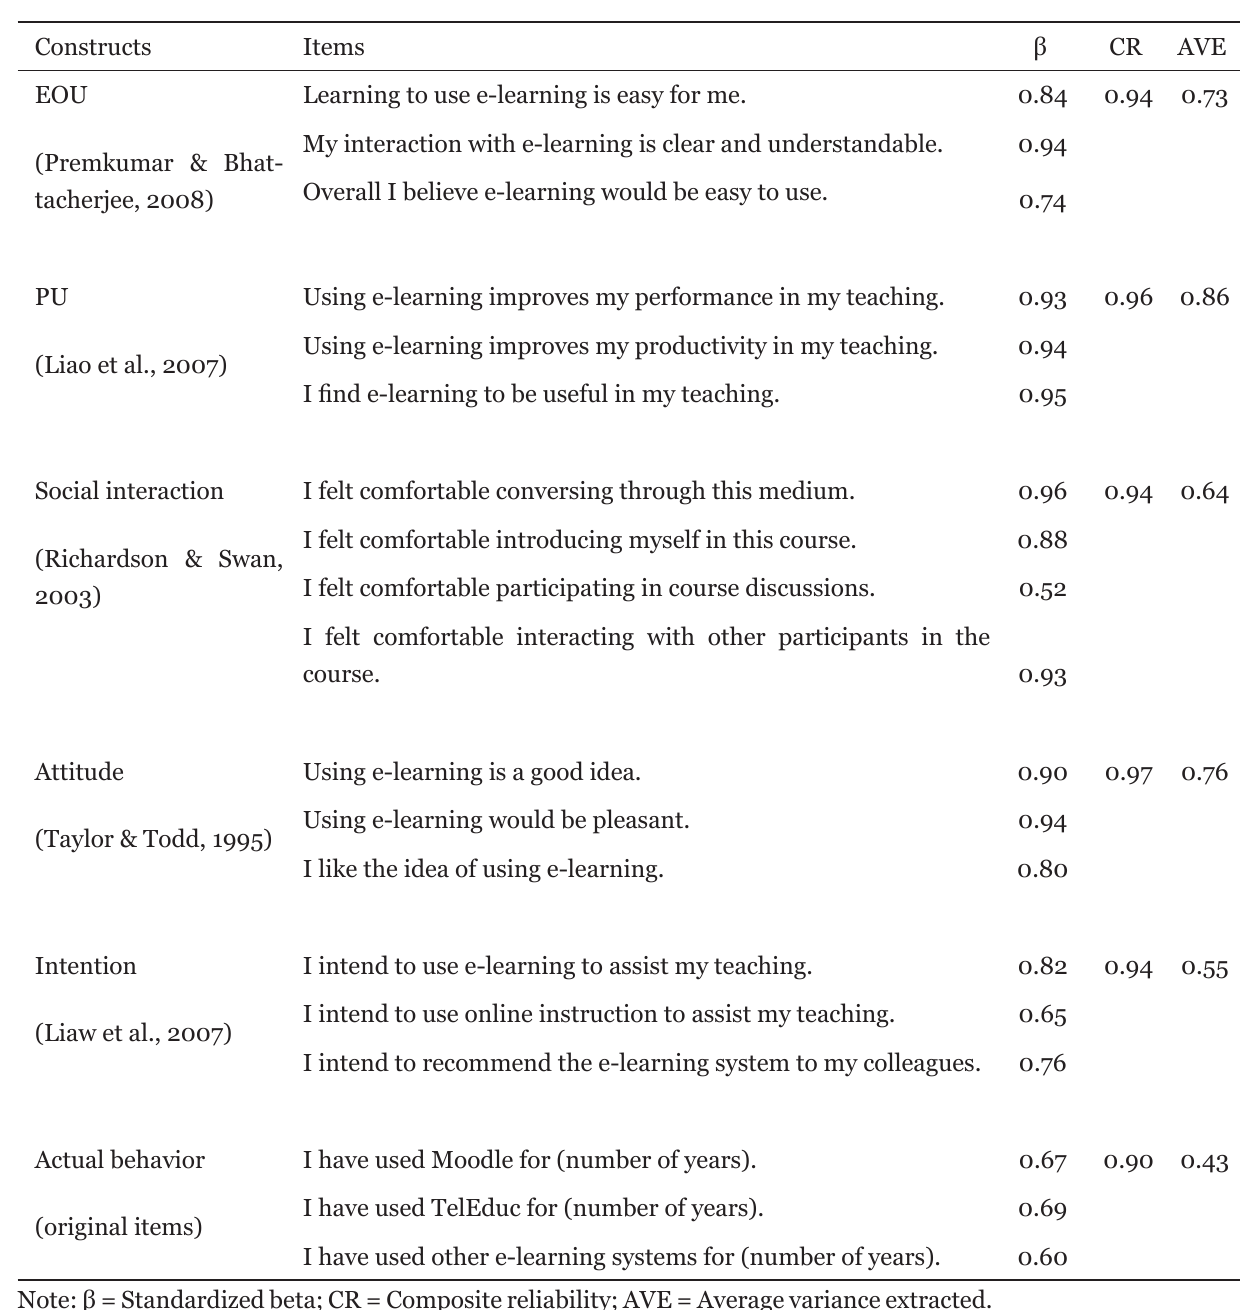
Table 1 Confirmatory Factor Analysis